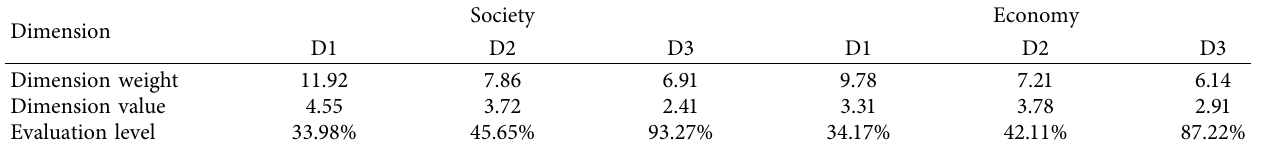
Figure 7: Comparison of two-time windows: (a) user trajectory time window and (b) sliding time window. Table 1: Values and levels of each dimension of the system under different